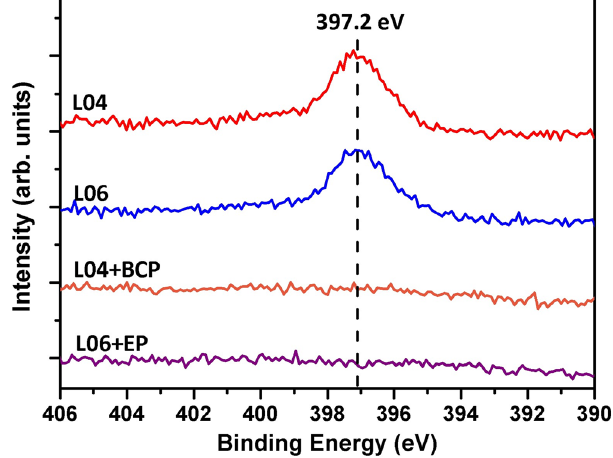
FIG. 5. N 1s XPS spectra (takeoff angle of 75°) of N-doped Nb samples before and after ∼ 6 μ m surface removal with BCP and EP.